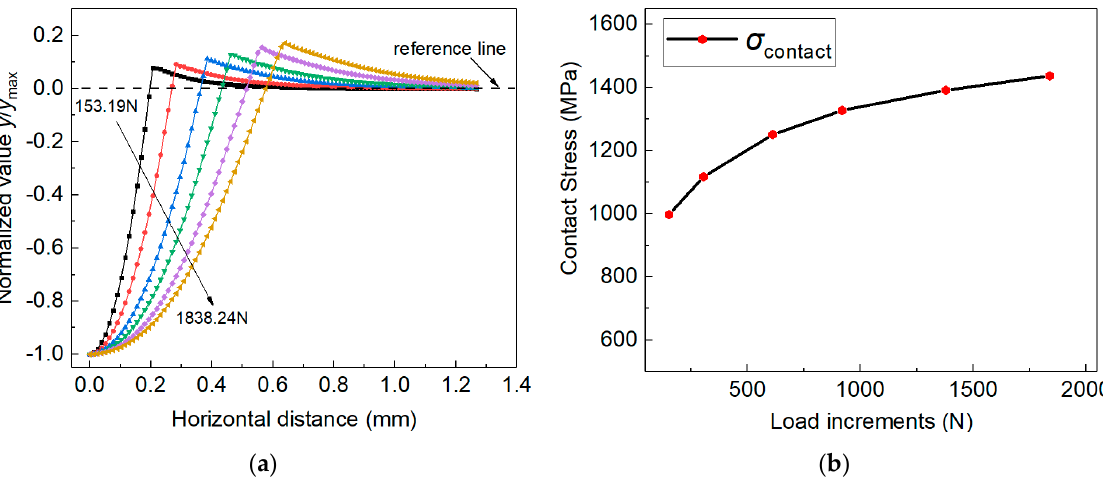
Figure 9. Evolution of indentation responses with the increase in indentation load/depth values: ( a ) the shape of imprint snapshot; ( b ) the contact stress values.